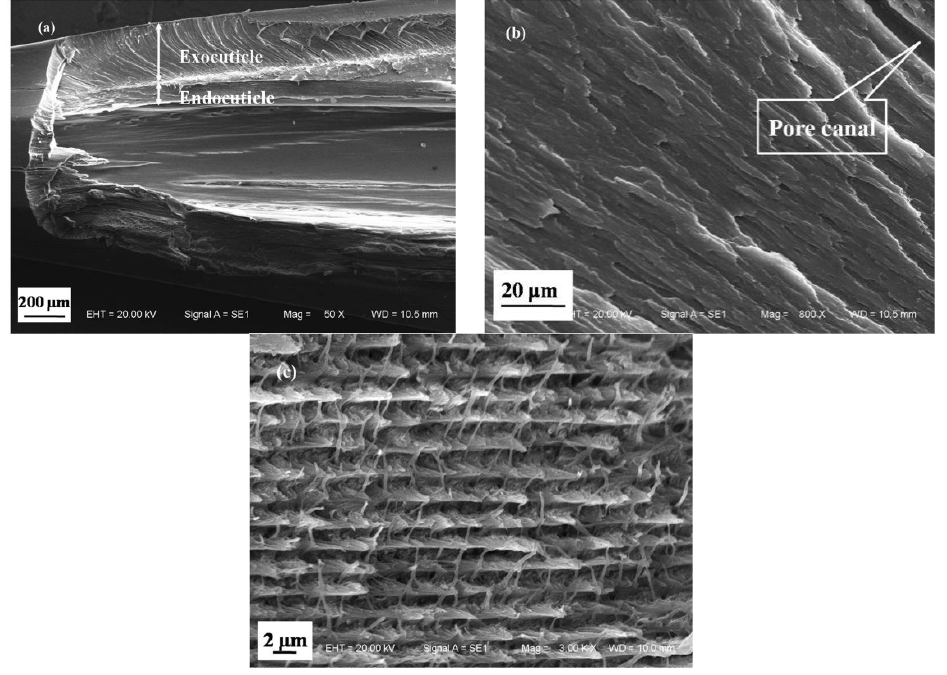
Figure 9. Longitudinal section of the tip of Chinese mitten crab dactylopodite: ( a ) Layered structure at tip of dactylopodite, ( b ) highly condensed structure of exocuticle, ( c ) Bouligand structure in endocuticle.